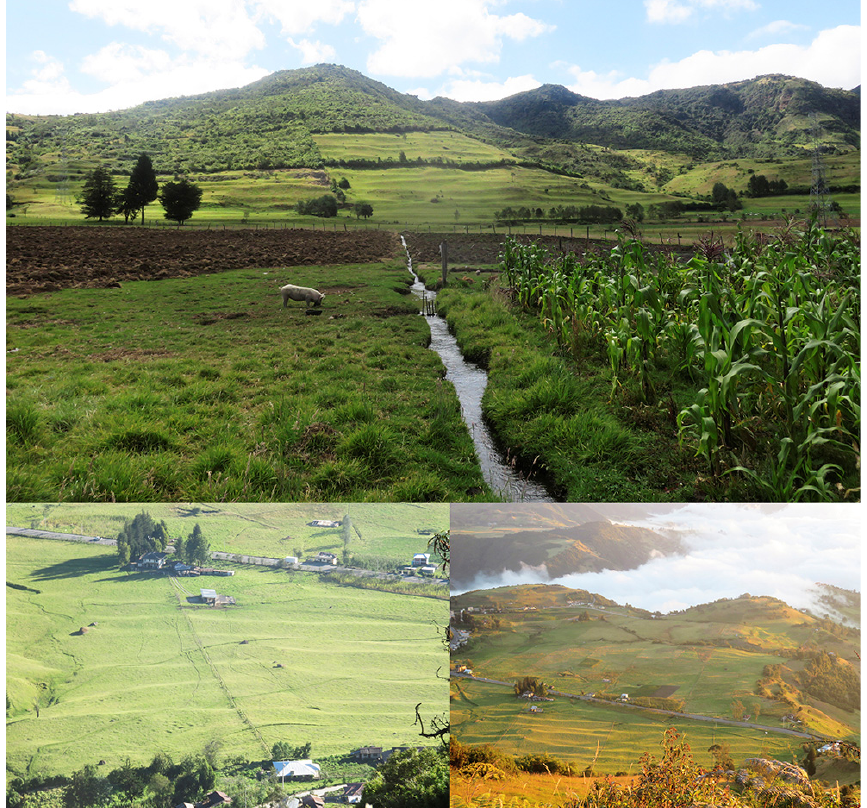
Figure 4. Joyagzhí archeological terraces in the Chanchán basin. Figure 4. Joyagzh í archeological terraces in the Chanch á n